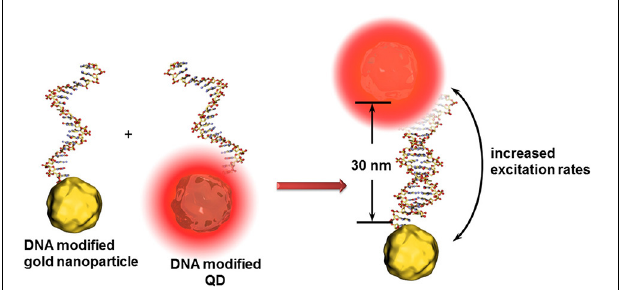
FIGURE 5 | Principle of the antenna effect of gold nanoparticles enhancing the excitation rates of QDs when positioned at ∼ 30nm.